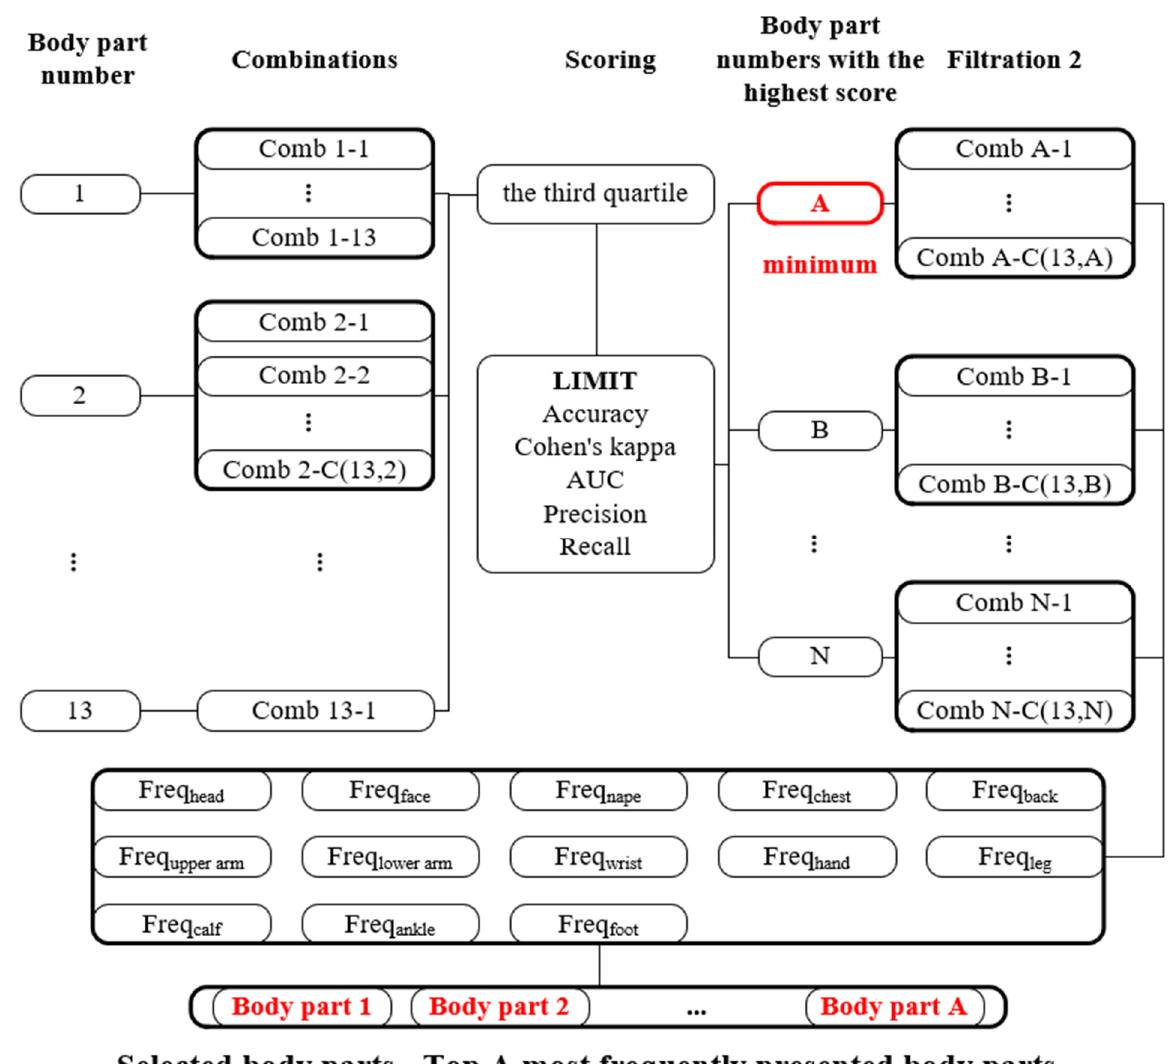
Figure 3. The method of selection for the fewest combination .